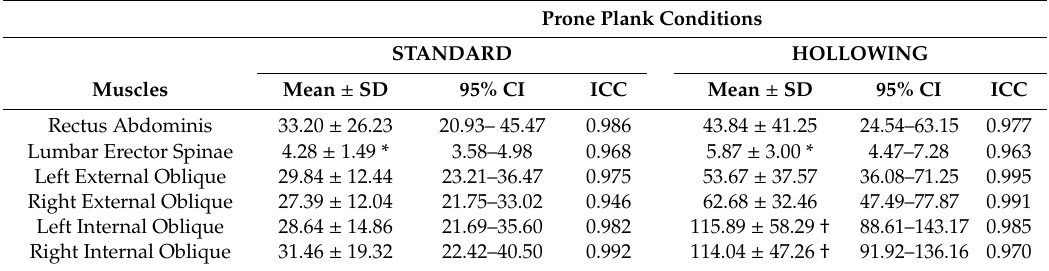
Table 2. Muscle activity (%MVC) in di ff erent prone plank